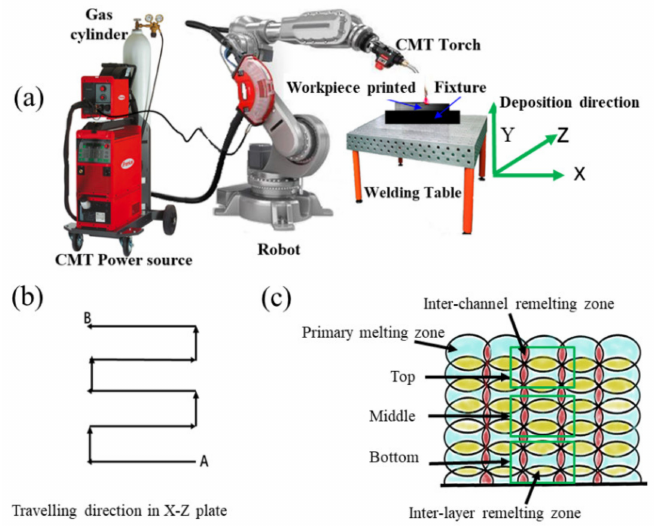
Figure 2. Schematic diagram of wire arc additively manufactured SS 321 by a CMT-WAAM system ( a ), the traveling ( b ), and the diagram of section and the sampling position of the SS 321 workpiece ( c